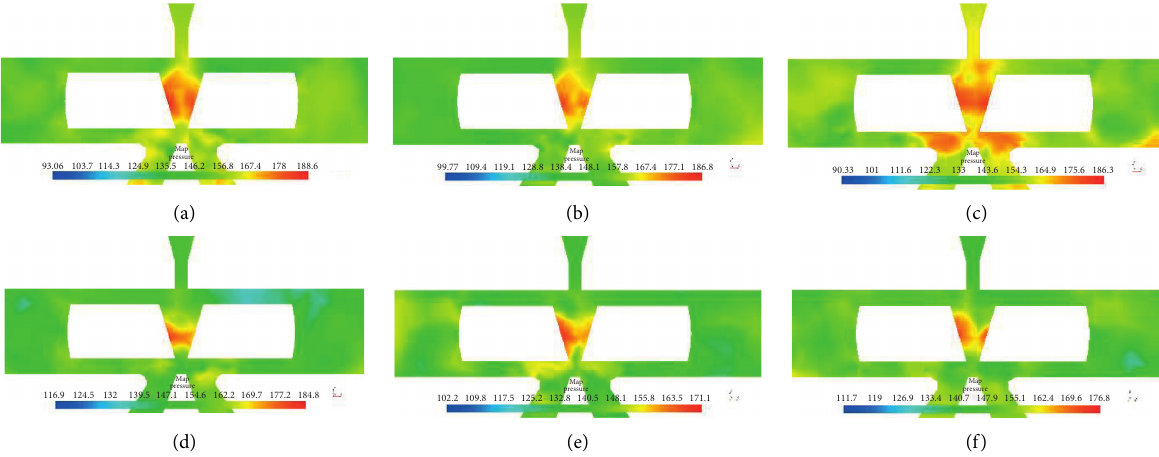
Figure 14: Sound pressure contours at different frequencies. (a) 100Hz. (b) 500Hz. (c) 1000Hz. (d) 2000Hz. (e) 3000Hz. (f) 4000Hz.